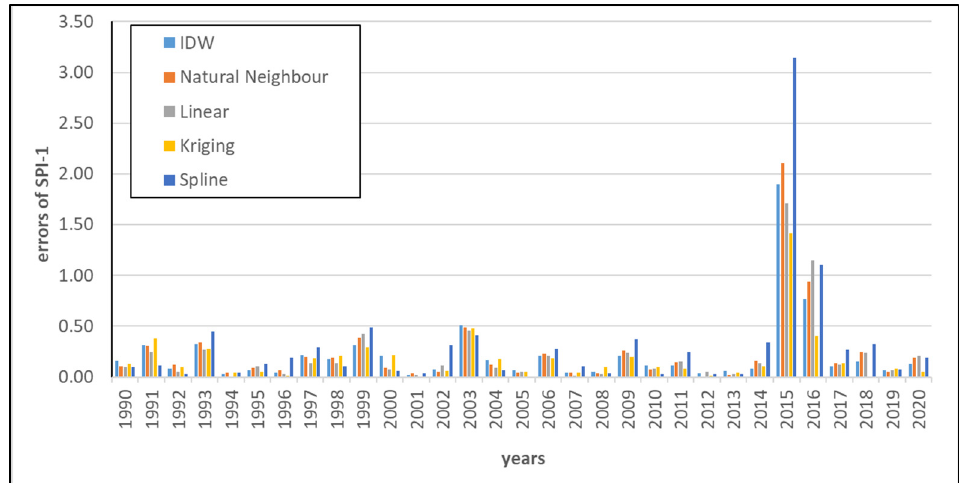
Figure 7. Example of disturbances in control stations, Dzie´ckowice, month: January, errors for each year of 1990–2020.